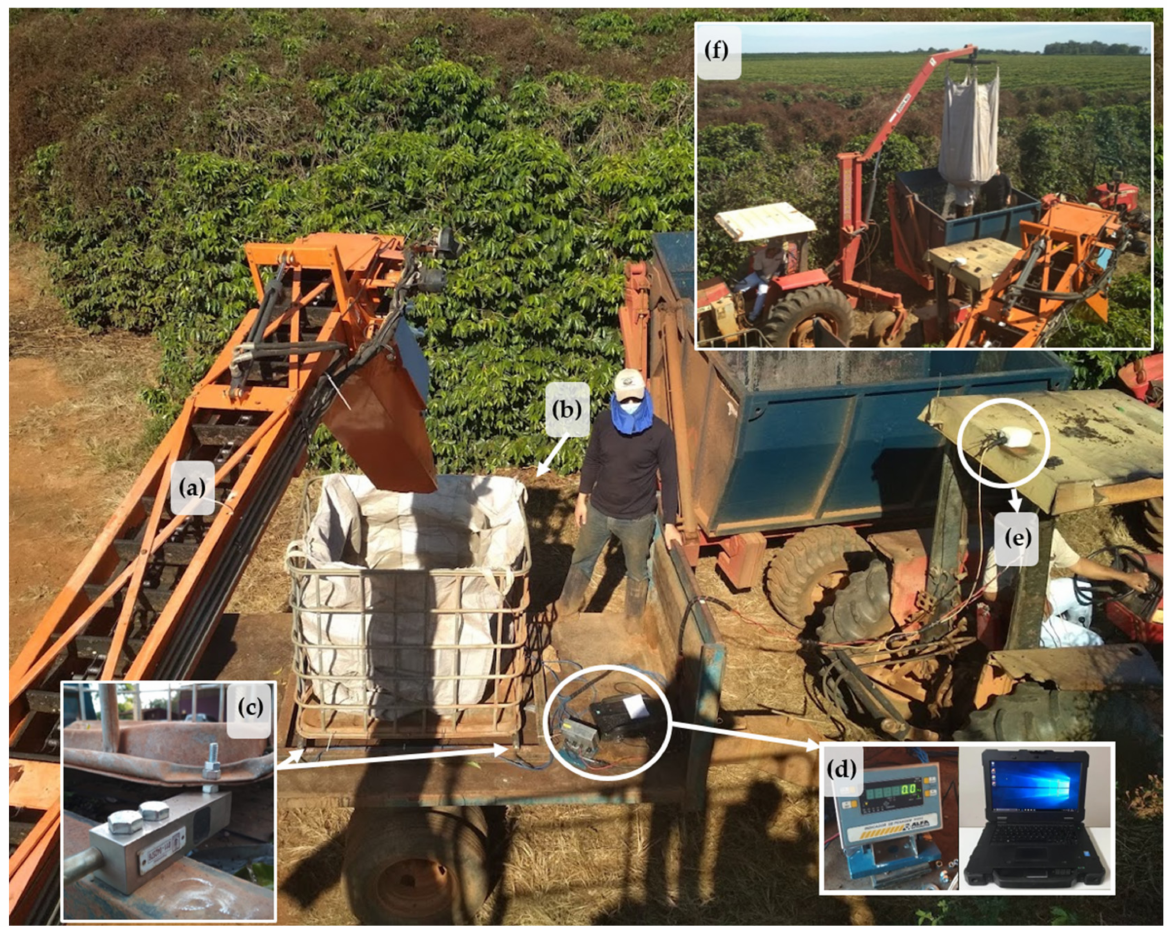
Figure 2. Details of the coffee wagon instrumentation used to measure the harvester’s yield data, loading ( a ); big-bag ( b ); load cells ( c ); data logger ( d ); GNSS receiver ( e ); unloading ( f